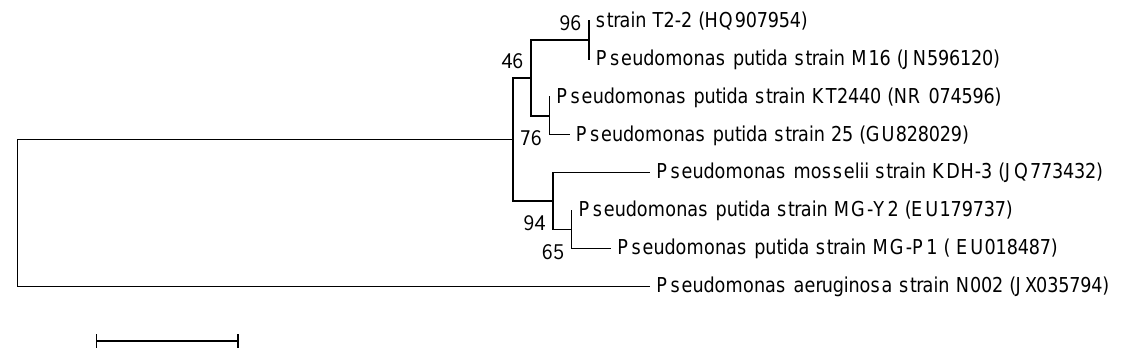
Figure 1. Phylogenetic analysis of oral bacterial strain T2-2. 16S rDNA-based phylogenetic tree showing the phylogenetic position of strain T2-2. A total of 1,529 unambiguously aligned nucleotides were analysed by using MEGA 5.2 as described in Materials and Methods. The barrepresents evolutionary distance as number of changes per nucleotide position, determined by measuring the lengths of the horizontal linesconnecting the corresponding species. P . aeruginosa strain N002 was used as outgroup. Numbers in parentheses are GenBank accession numbers.